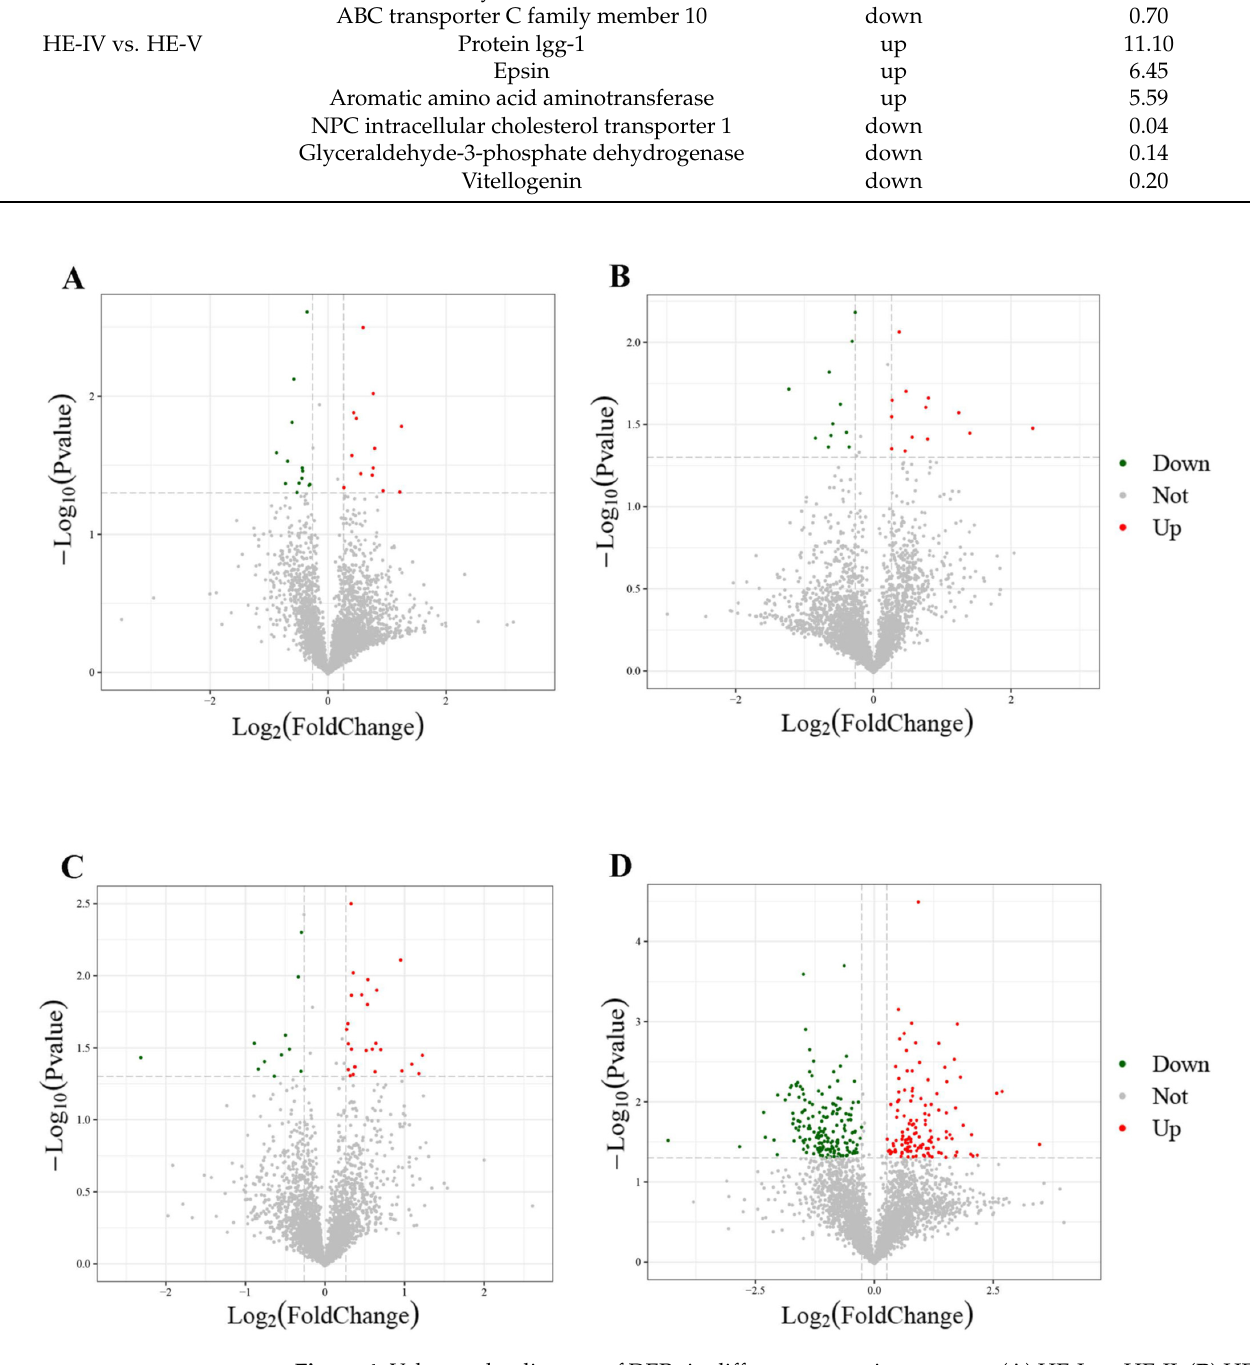
Figure 4. Volcano plot diagram of DEPs in different comparison groups. ( A ) HE-I vs. HE-II, ( B ) HE-II vs. HE-III, ( C ) HE-III vs. HE-IV, ( D ) HE-IV vs. HE-V. Red dot indicates upregulated DEPs and green dot represents downregulated DEPs. Table 2. Top 3 up/down regulated DEPs identified in hepatopancreas of M. nipponense in four com- pared groups.